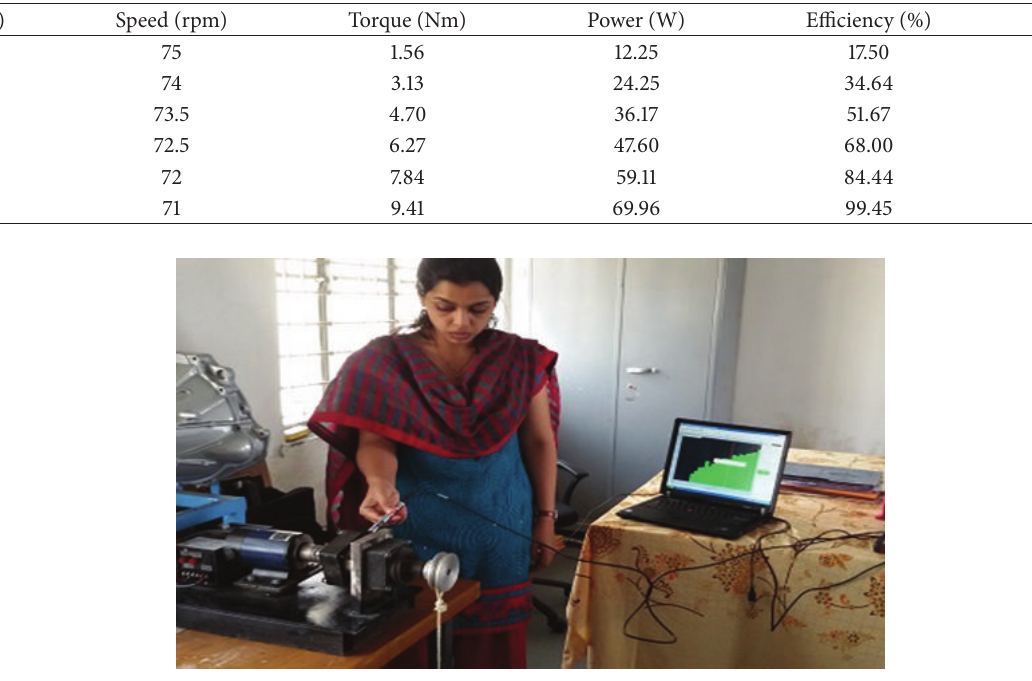
Figure 6: Recording results on sound meter and FFT spectrum analyzer.